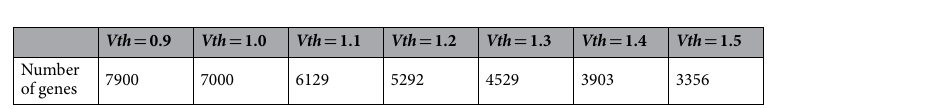
Figure 6. Expression pattern of causal genes in both stages.